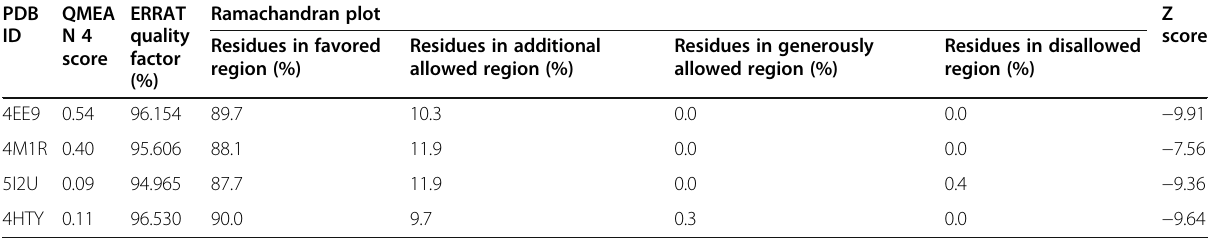
Table 5 Comparison of QMEAN4, ERRAT, Ramachandran plot, and Z score for the quality assessment of three-dimensional structures PDB QMEA ID N